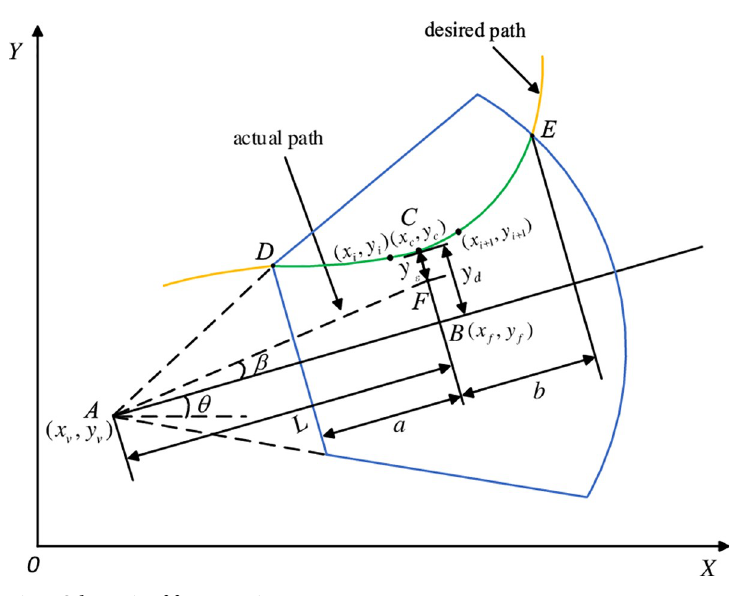
Fig 4. Schematic of focus